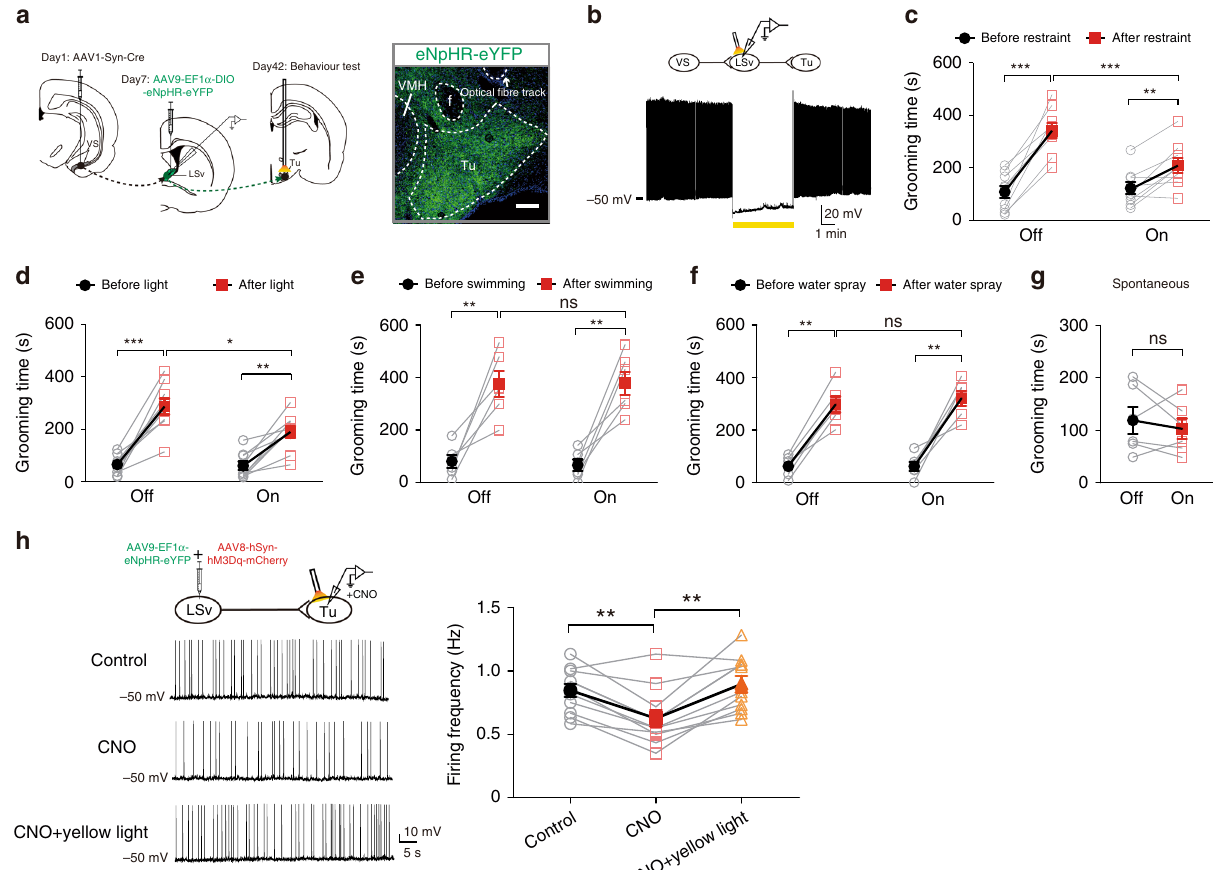
Fig. 9 Activation of LSv neurons is necessary for emotional stress-induced grooming. a Schematics for optogenetics manipulation. Targeted functional inhibition of the VS → LSv → Tu circuitry was achieved by injection of AAV1-Syn-Cre into VS, AAV9-EF1a-DIO-eNpHR-eYFP into LSv and implantation of optical fi bre onto Tu. Scale bar 500 μ m. b Whole-cell recordings from LSv neurons in brain slices obtained from these animals validated eNpHR-mediated inhibition via prolonged (5 min) yellow light delivery. c – f While signi fi cant increases in grooming time were found in light-off control group following body restraint ( c , n = 9) and light exposure ( d , n = 9), the increases in grooming time were signi fi cantly smaller when light was delivered. In contrast, the increases in grooming time after swimming ( e , n = 6) and water spray ( f , n = 6) were similar in both light-off and light-on trials. ns not signi fi cant; * P < 0.05; ** P < 0.01; *** P < 0.001, two-way repeated measures ANOVA with Sidak post-hoc test. g Optogenetic inhibition did not affect the time that the animal spent in spontaneous grooming. n = 6, P = 0.4861; Student ’ s paired two-tailed t -test. h Targeted functional activation and inhibition LSv terminals in Tu by injection of AAV9-EF1a-eNpHR-eYFP and AAV8-hSyn-hM3Dq-mCherry into LSv and recording in Tu neurons. The spontaneous fi ring of Tu neurons induced by − 50 mV holding level can be partially inhibited by applying CNO and recovered by yellow light stimulation. ( n = 11, one-way repeated measures ANOVA with Tukey post-hoc test; ** P < 0.01). All data are presented as mean ± SEM. See also Supplementary Table 3 for further statistical information. Source data are provided as a Source Data fi